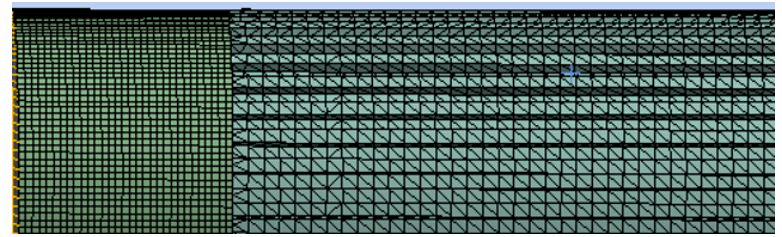
Figure 8. Hybrid mesh on the generator rotor portion.